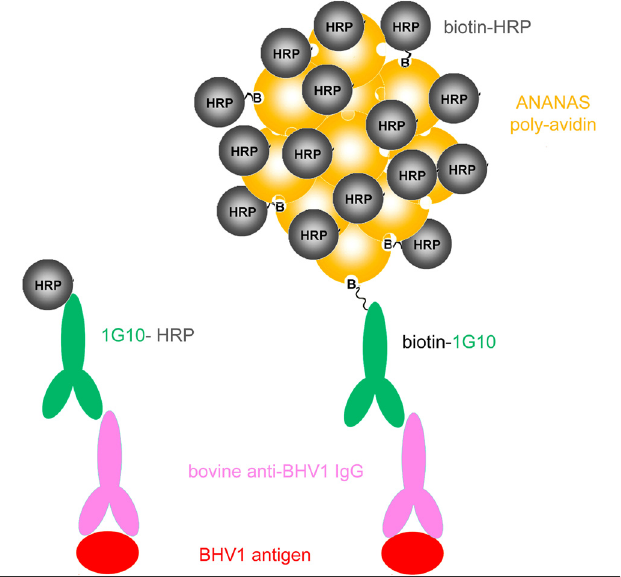
Fig 1. Cartoon (not in scale) depicting the two 1G10 mAb-based ELISAs for detection of anti BoHV-1 antibodies: classic configuration using the antibody-HRP conjugate (left) and ANANAS integrated method (right). For simplicity reasons, the mAb used for Bo-HV1 adsorption on the plate (see methods) is not included in the